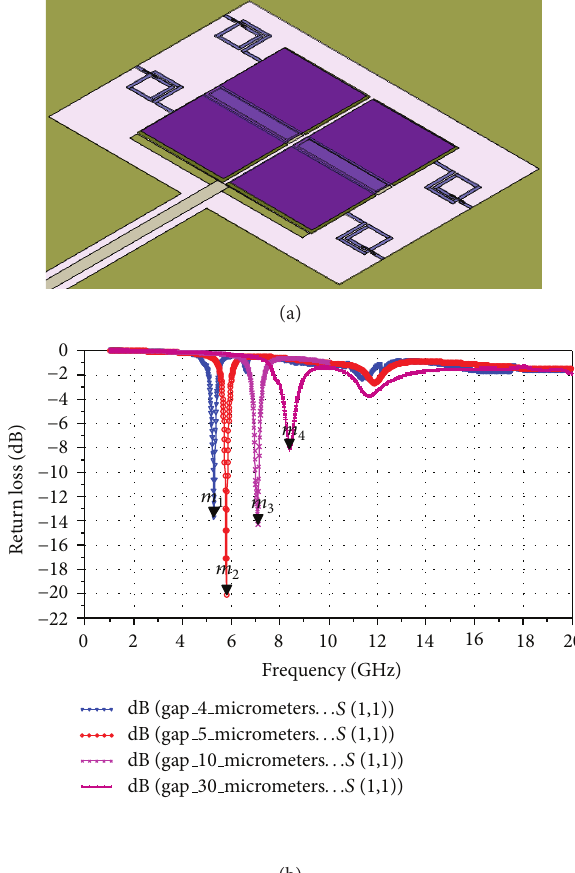
F 5: Full-wave simulation for the antenna using HFSS: (a) sketch of the antenna, and (b) simulated S